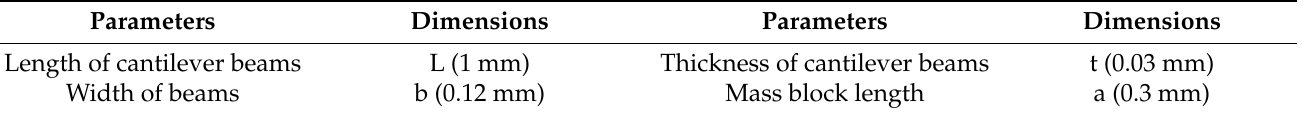
Table 1. Dimensions and parameters.